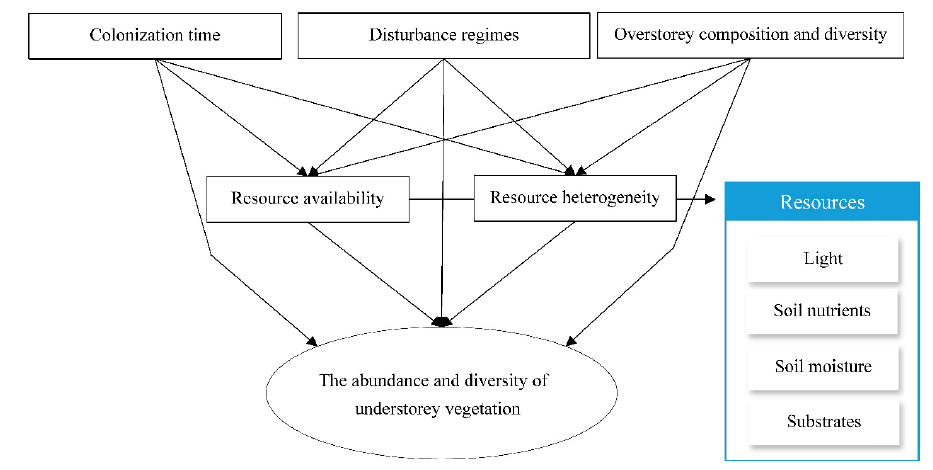
Figure 1. A conceptual model of hypothesized relationships showing how colonization time, disturbance regimes, overstorey composition and diversity, resource availability and heterogeneity influence the abundance and diversity of the understorey vegetation.